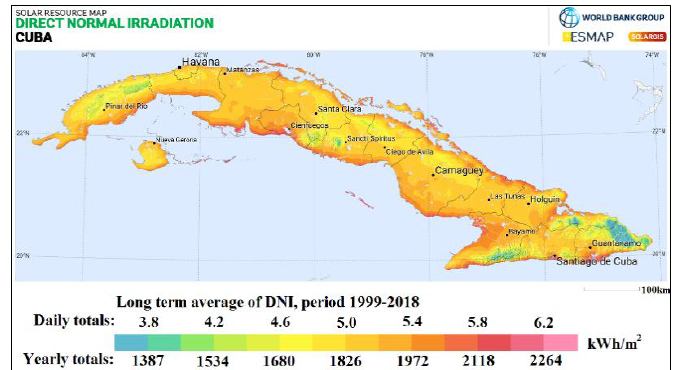
Figure 1: Cuba direct normal irradiation